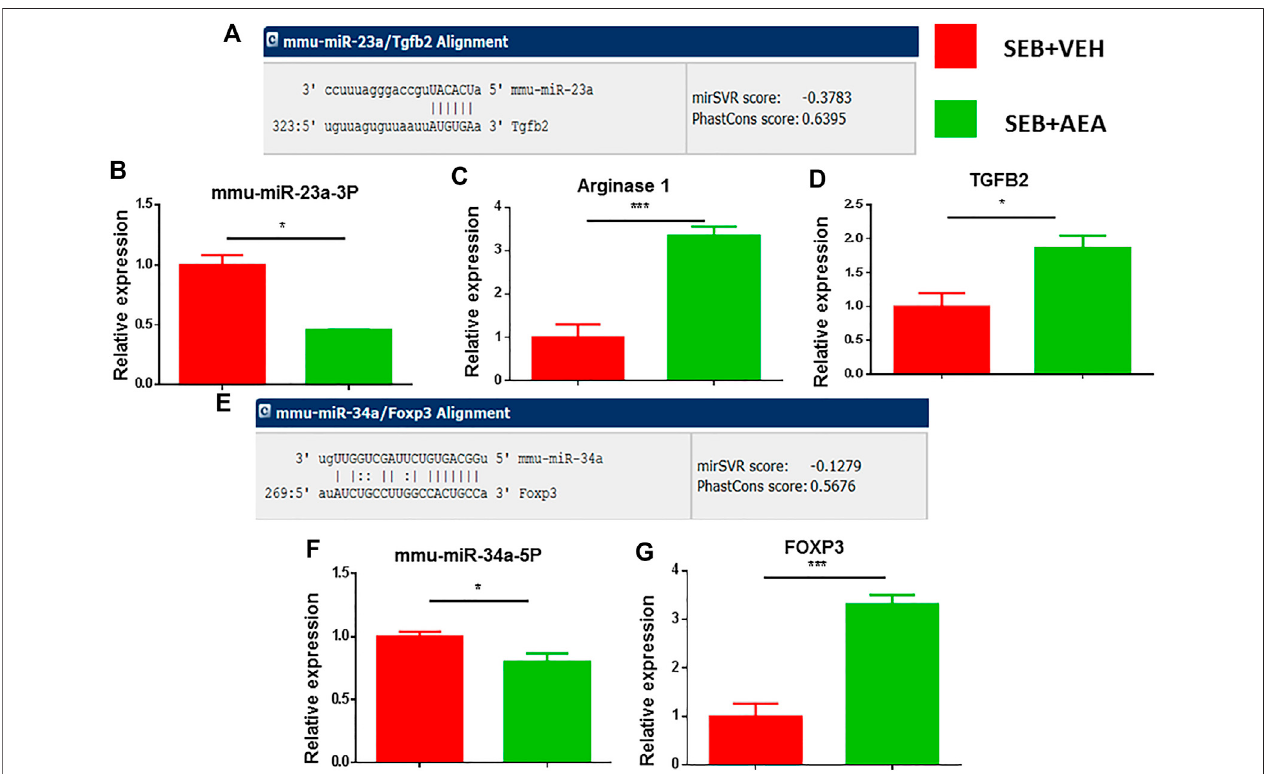
FIGURE 6 | Validation of select miRNAs and targeted genes. Mice were treated with SEB and AEA as described in Figure 1 legend. Mononuclear cells from the lungsofbothgroupswereisolatedandscreenedforexpressionofmiRNAexpressionwiththeirtargetedgenesbyqRT-PCR. (A) Bindingaf fi nitybetweenmiRNA23a-3p and targeted genes including ARG1and TGF β 2. (B) miRNA 23a-3p expression. (C,D) Expression of ARG1and TGF β 2. (E) Binding af fi nity between miRNA 34a-5p and targeted gene FOXP3. (F) Expression of miRNA 34a-5p. (G) Expression FOXP3. Statistical signi fi cances as p ≤ 0. 05, ** p ≤ 0. 01, *** p ≤ 0.